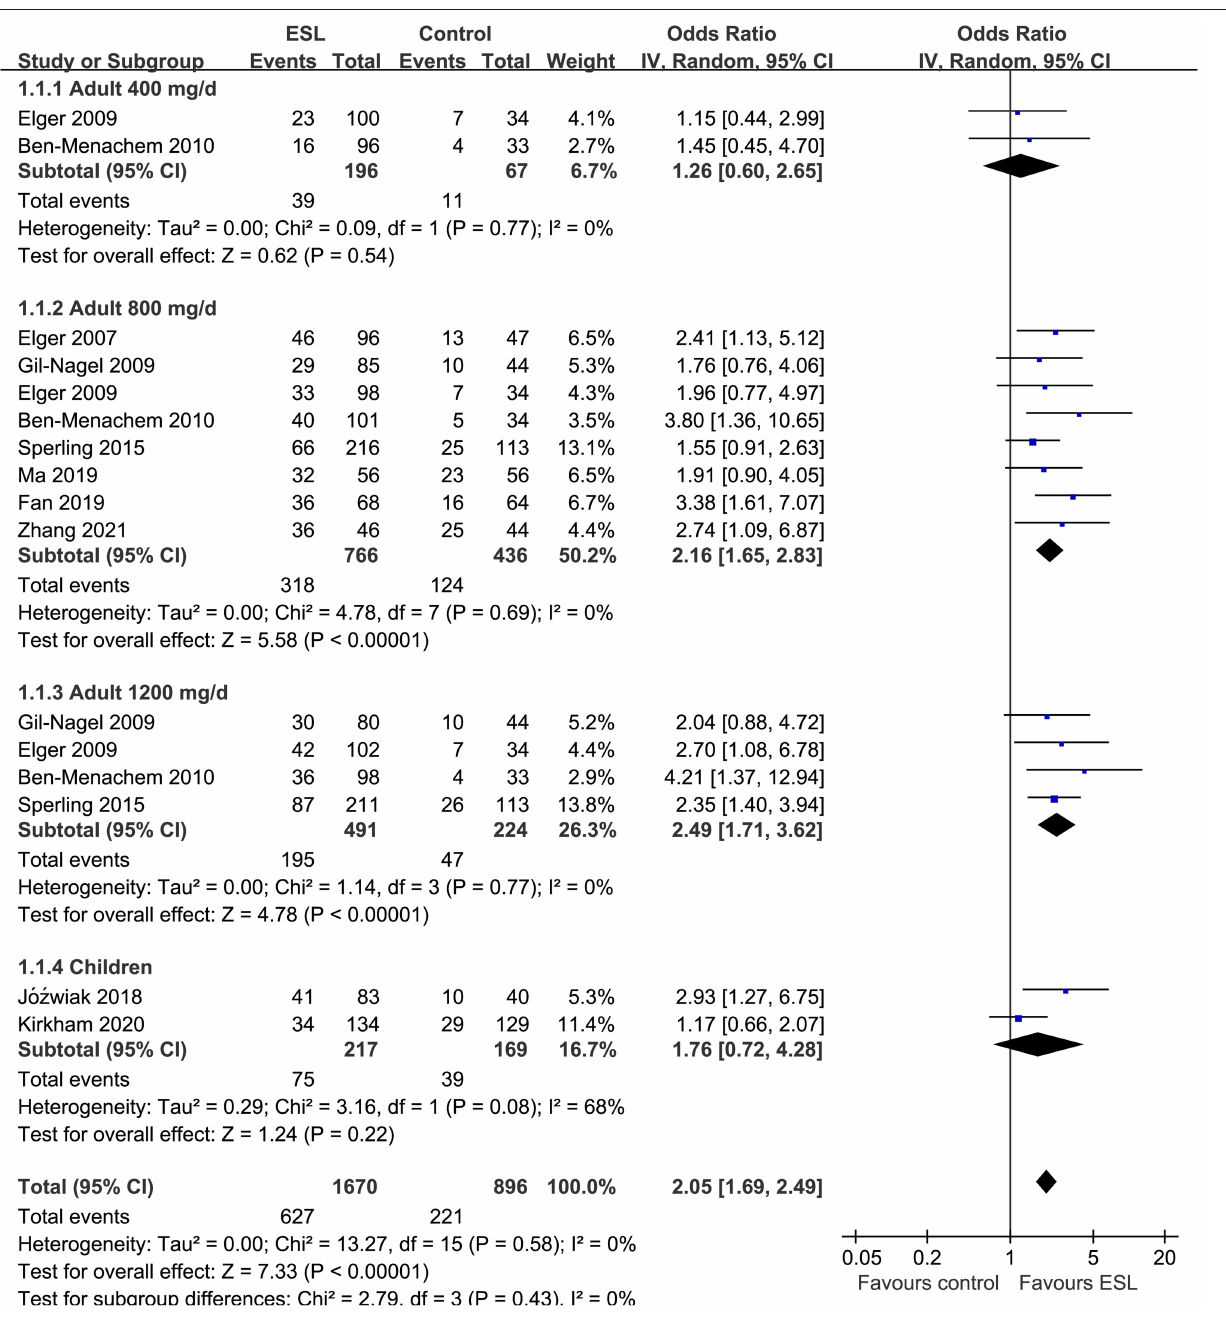
2.16, 95% CI: 1.41–3.30, p < 0.001; I 2 = 0%; Figure 3 ). Although the overall AE was increased in people with ESL (OR 1.58, 95% CI 1.21–2.06, I 2 = 0%; Figure 4 ), the incidence of severe AE (OR 1.58, 95% CI: 0.90–2.78, p = 0.11, I 2 = 0%; Figure 5 ). Since CI: 1.54–2.92, p < 0.001, I 2 = 0%) and the effective rate (OR 2.37, 95% CI: 1.41–4.01, p = 0.001, I 2 = 0%) in adults,